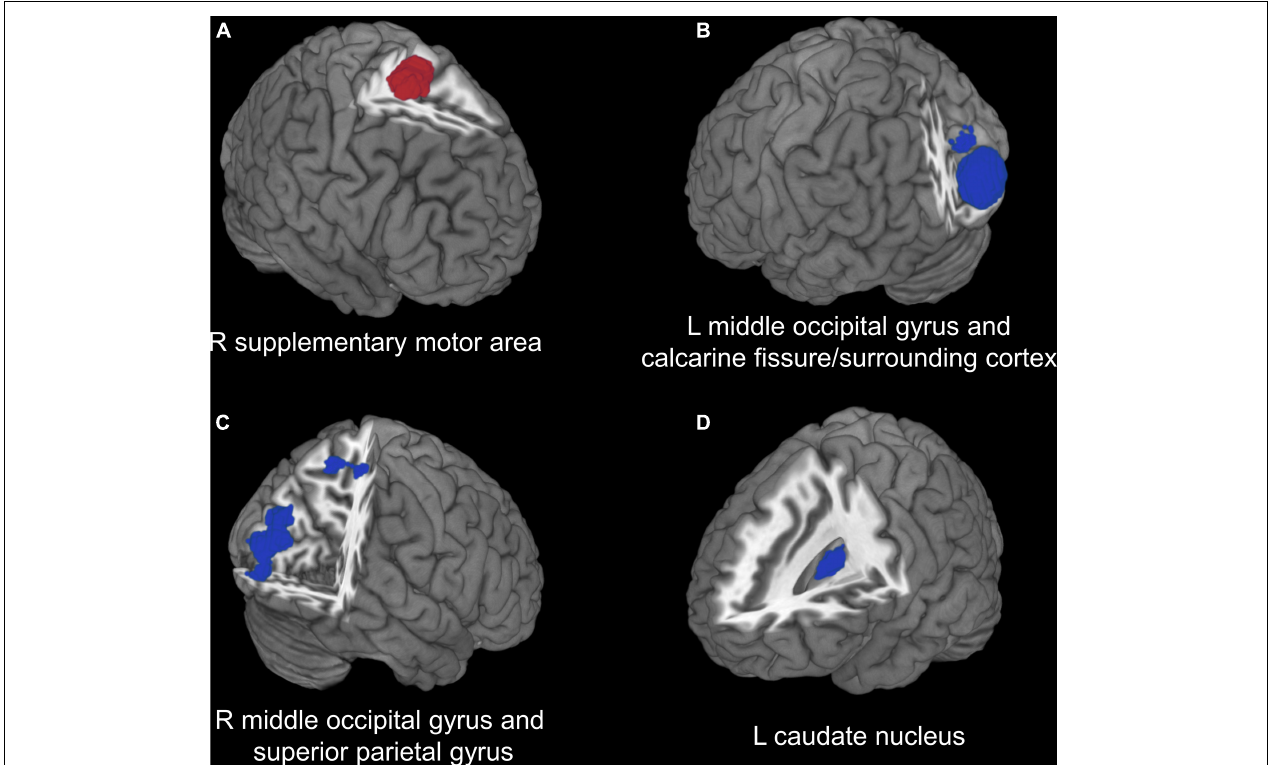
FIGURE 2 | Voxel-based meta-analysis results of regions with cerebral perfusion alterations in T2DM. (A) Red region indicates increased CBF in patients with T2DM compared with healthy controls. (B–D) Blue regions indicate decreased CBF in patients with T2DM compared with healthy controls. T2DM, type 2 diabetes mellitus; CBF, cerebral blood flow; R, right; L,